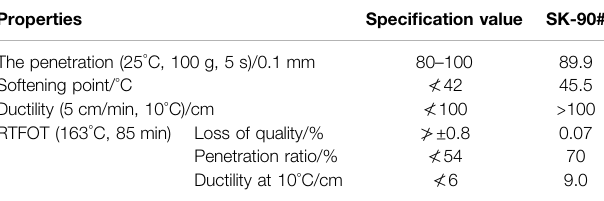
TABLE 2 | Properties of SK-90# asphalt.